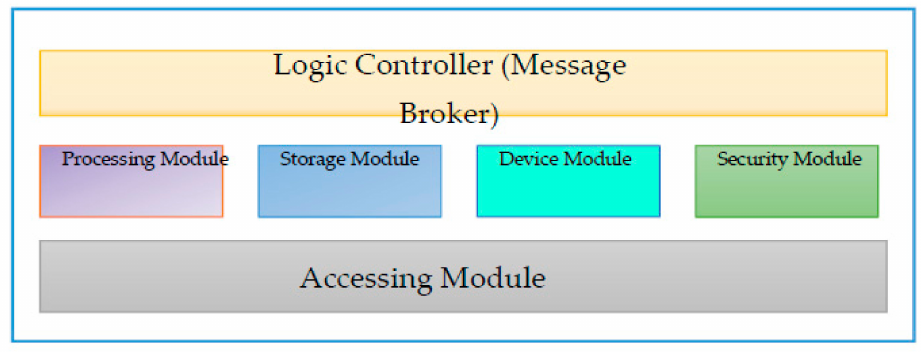
Figure 2. General architecture of the fog